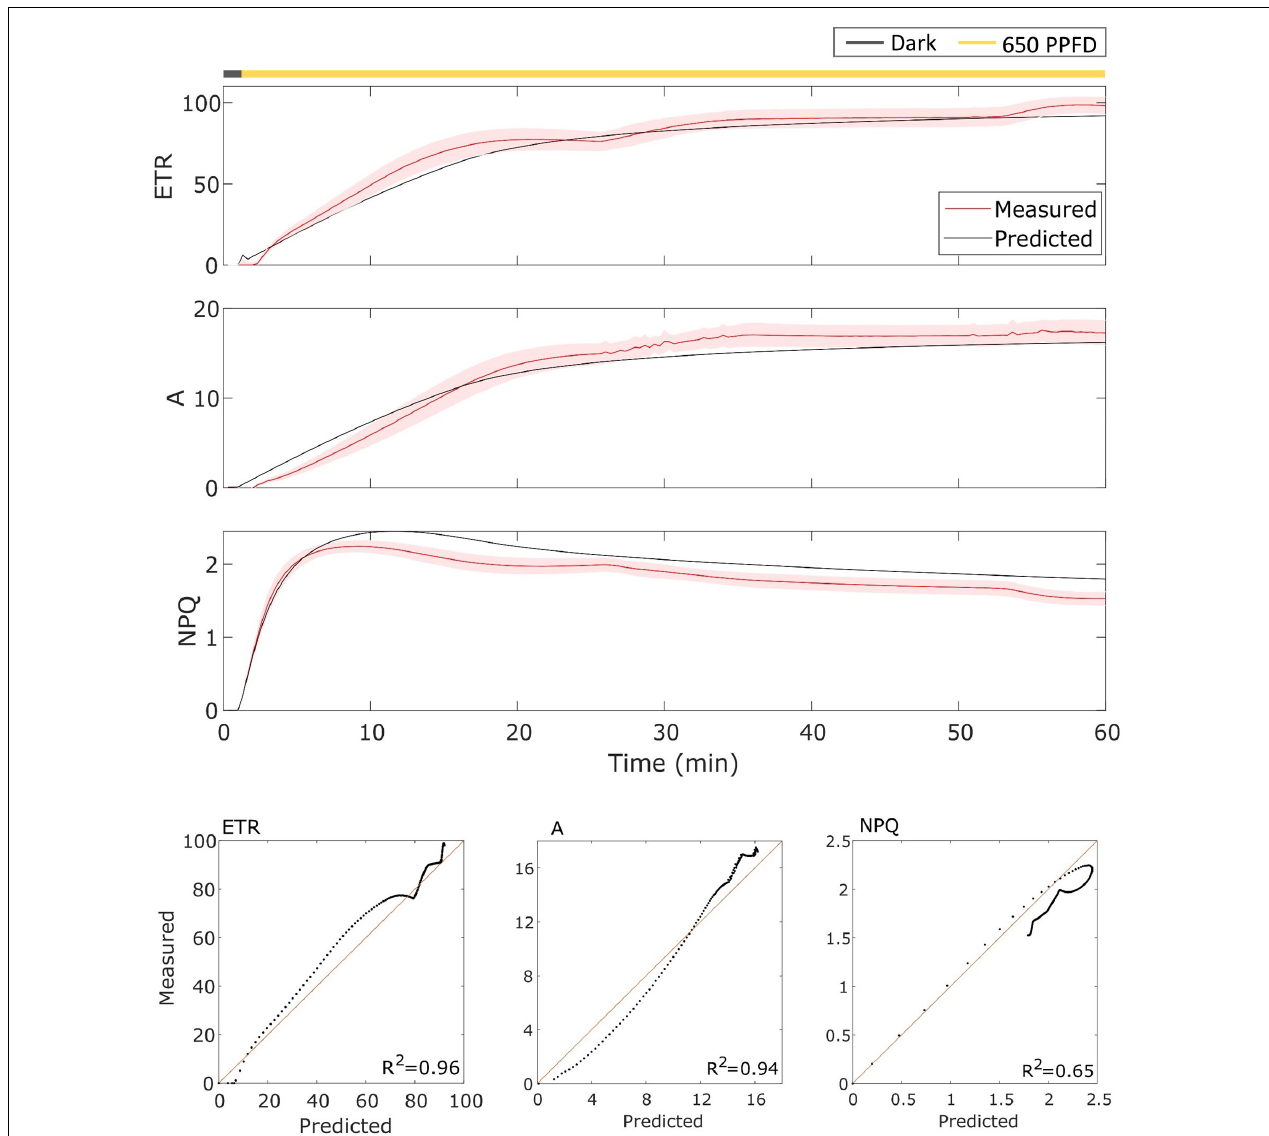
FIGURE 5 | (Top) Eiko data (indicated in red) compared with model results (indicated in black) in constant light. The data are shown as means of three replicates (indicated as a red continuous line) and their standard error (indicated as the red shaded area around the mean value). (Bottom) Parity plots for ETR, A , and NPQ with related R 2